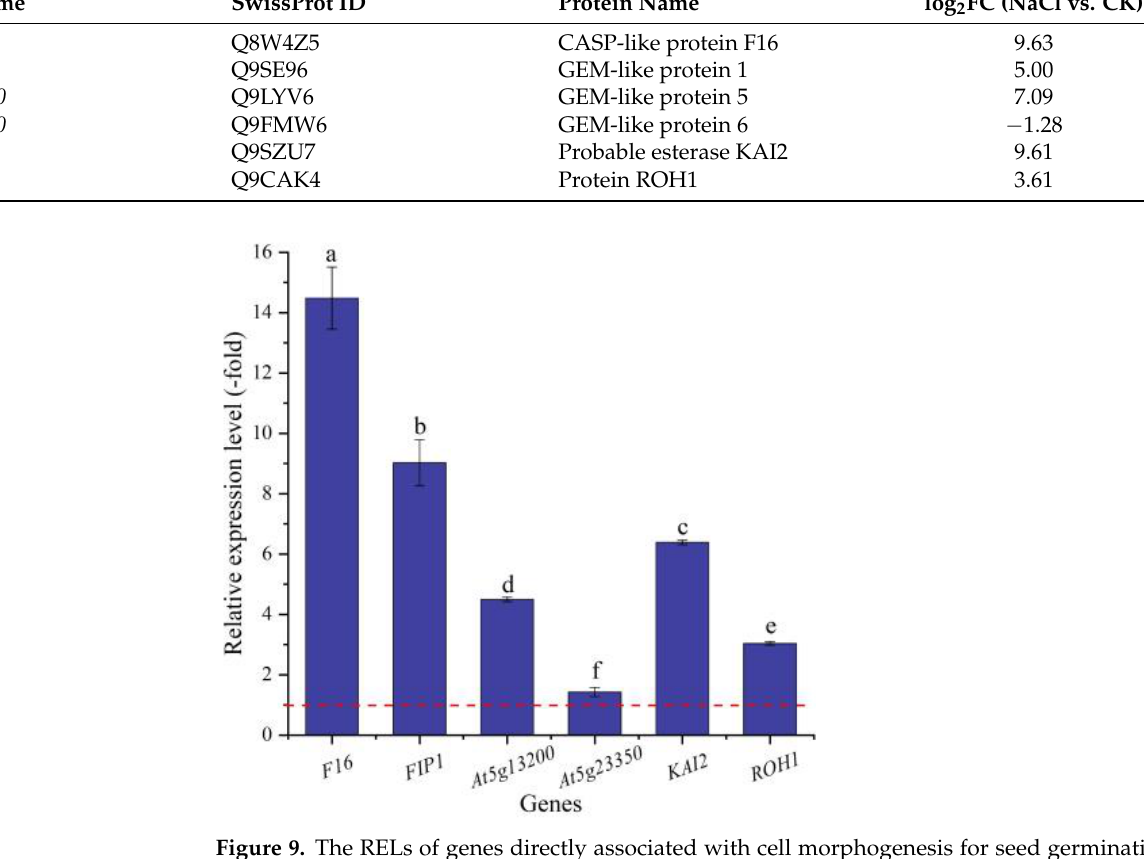
Figure 9. The RELs of genes directly associated with cell morphogenesis for seed germination in A. venetum seeds at 300 mmol/L NaCl vs. CK (mean ± SD, n = 3). Different letters represent a significant difference ( p < 0.05) among different genes. The red dotted line differentiates UR (>1) and DR (<1).